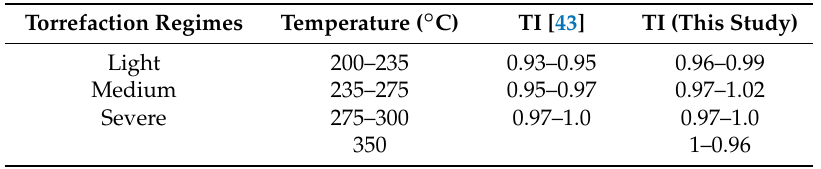
Table 2. TI in different